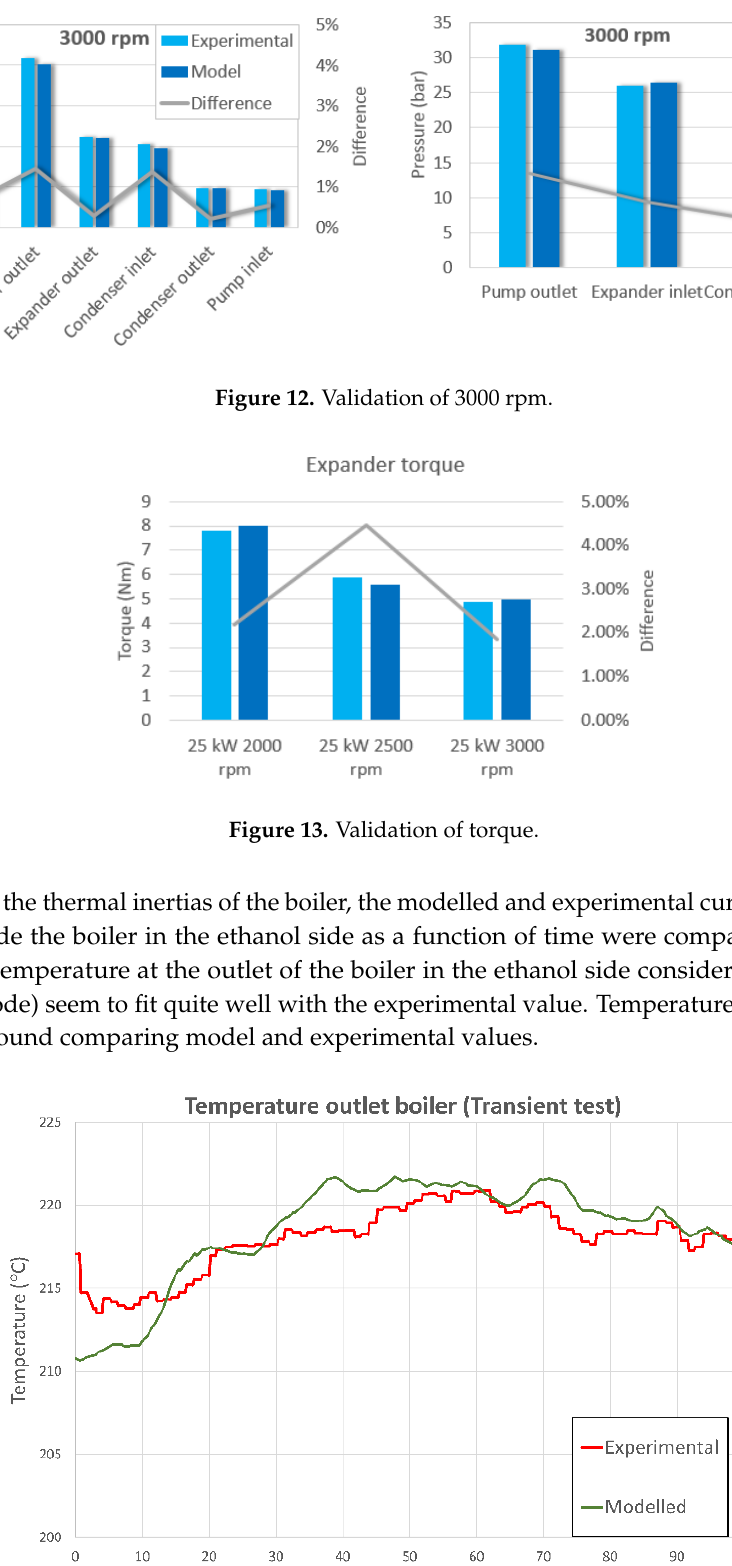
Figure 15. P - V Diagram 3000 rpm.